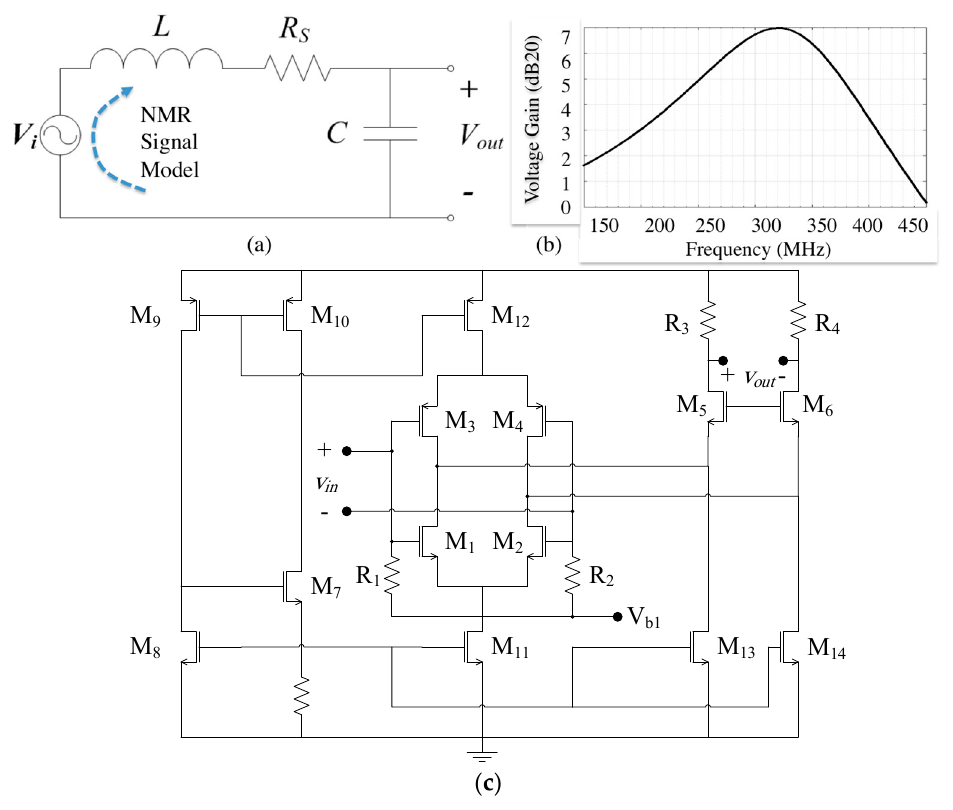
Figure 7. Low noise amplifier ( a ) Pre-amplifier equivalent circuit ( b ) voltage gain of preamplifier; ( c ) schematic of LNA circuitry.